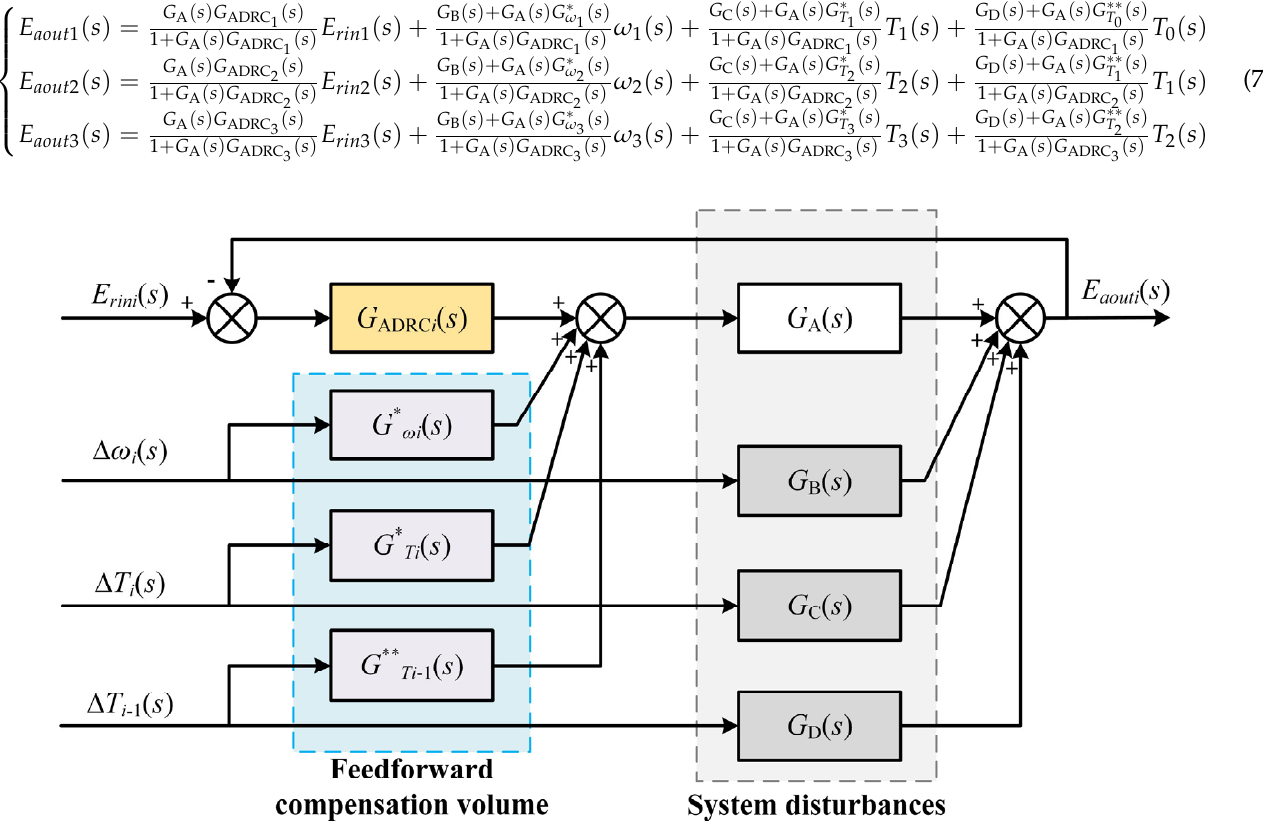
Figure 3. The structure of the feedforward controller.